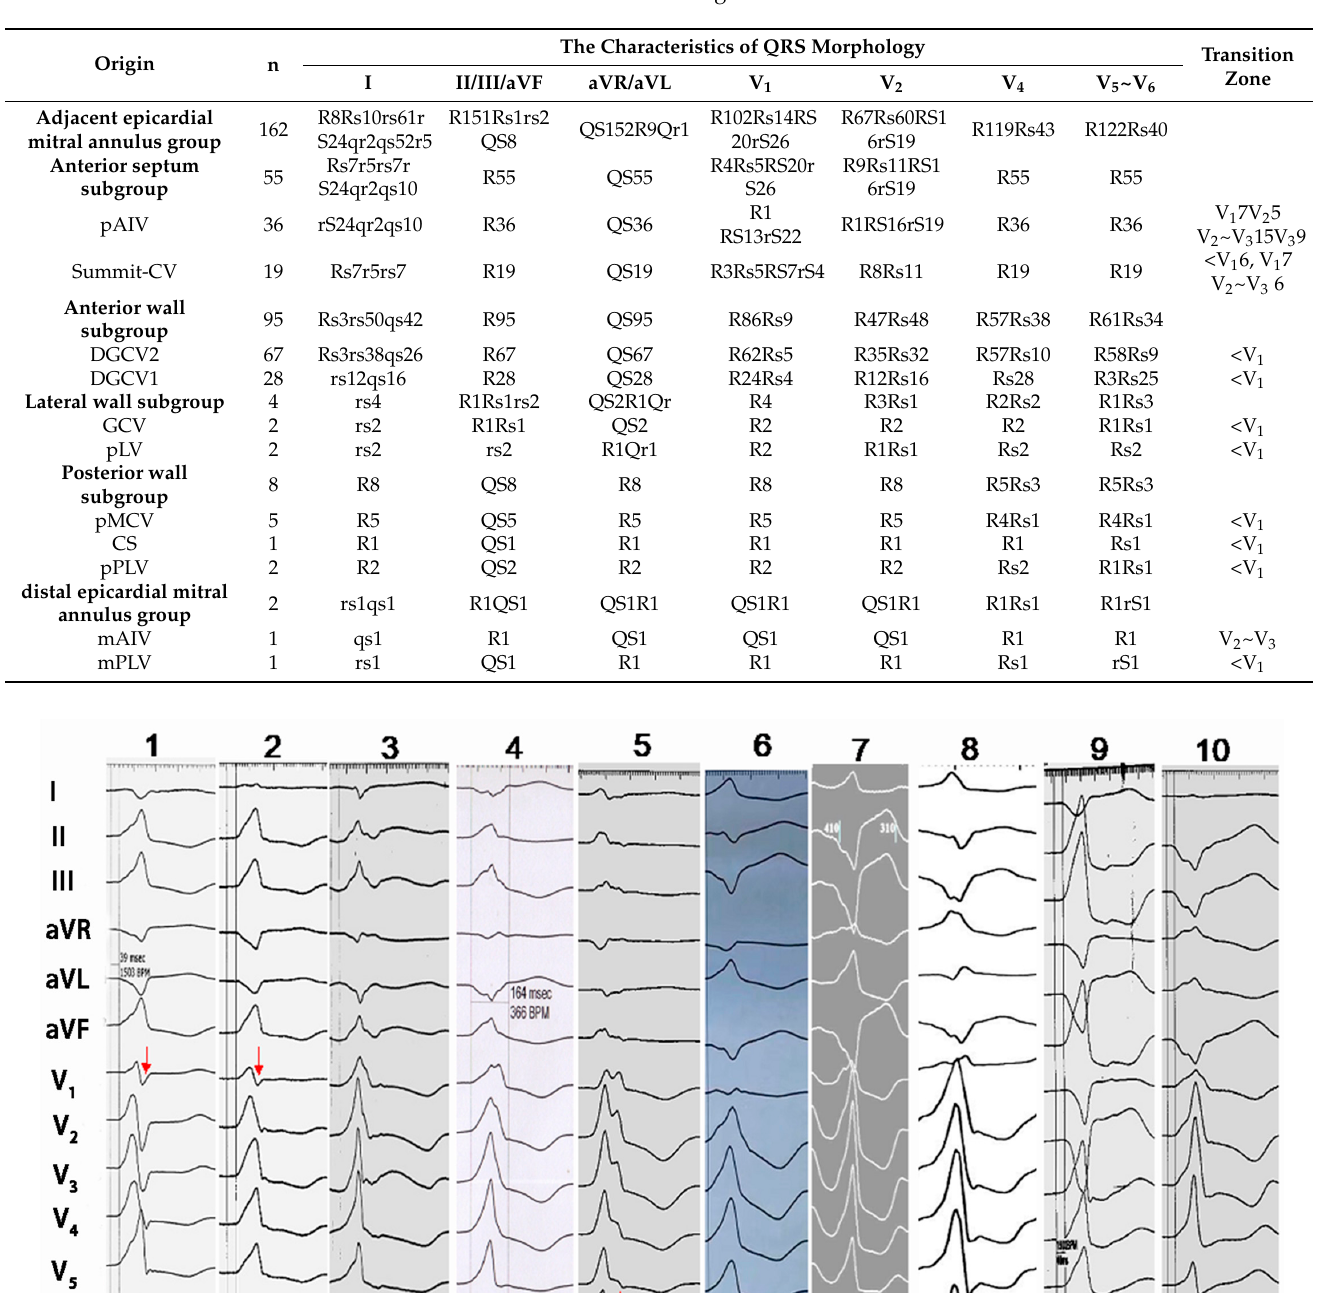
Table 3. ECG characteristic of IVAS origin from the CVS.